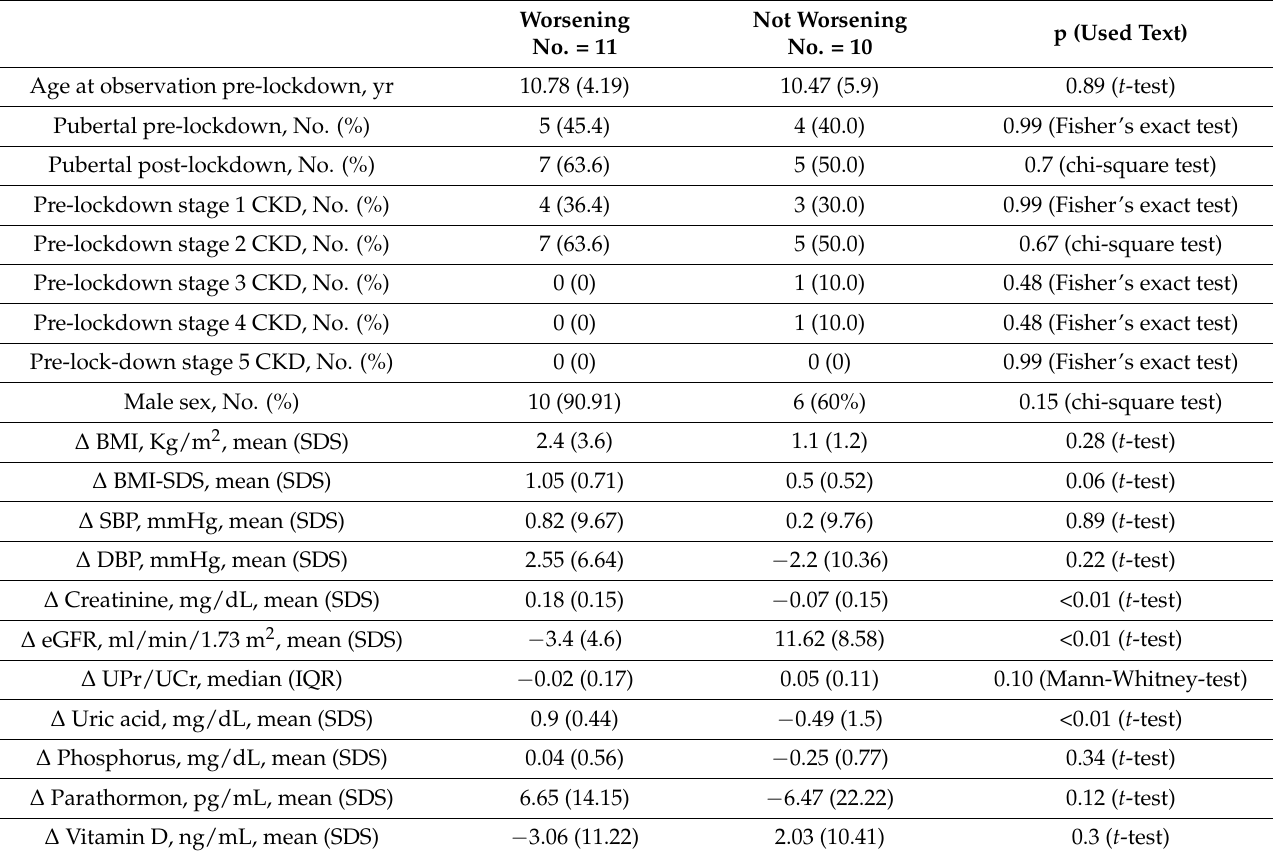
Table 2. Clinical and biochemical characteristics of patients presenting or not worsening of chronic kidney disease. For continuous normally distributed variables means ± SDS are shown, while for non-normally distributed variables median and interquartile range are